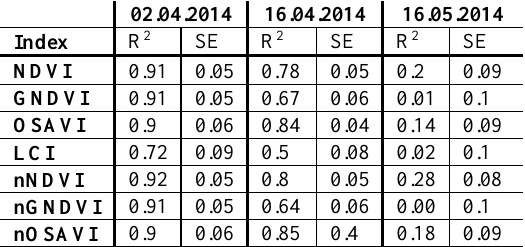
Table 2. R 2 values and standard error (SE) for regression analysis of RGBVI vs. VIs listed in Table 1 (p < 0.01)